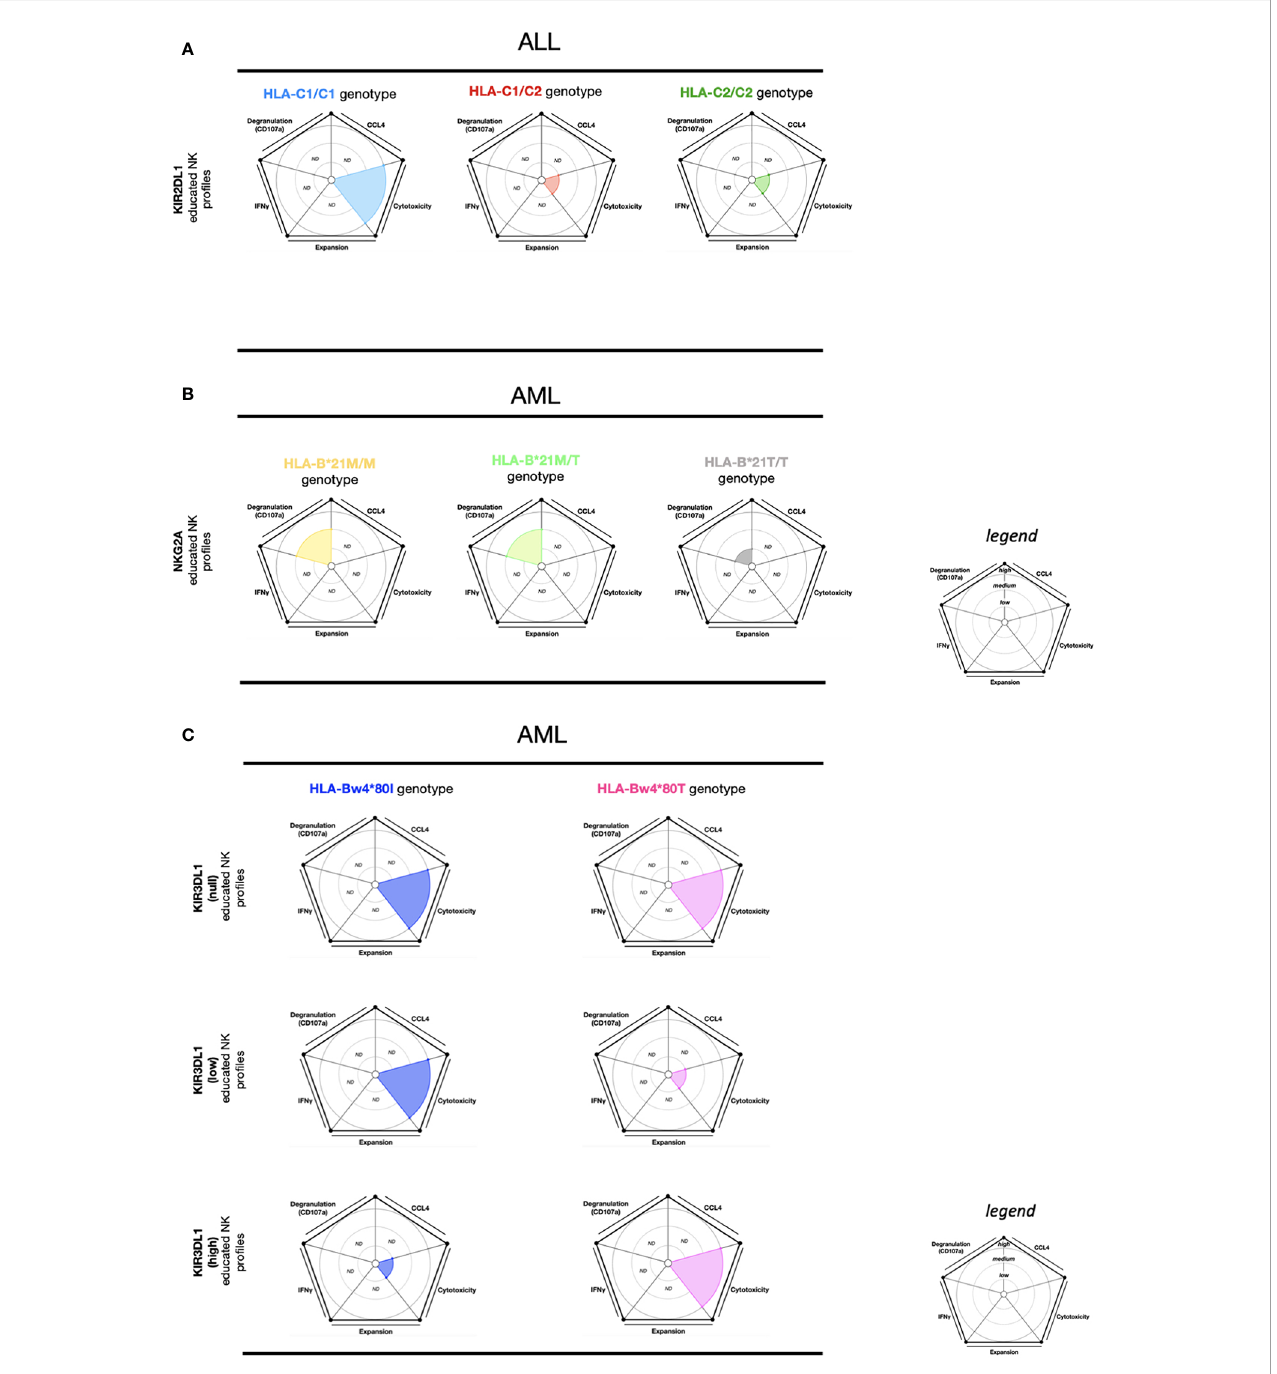
FIGURE 4 NK cell education pro fi les related to ALL and AML tumors. The different colors each represent a speci fi c-NKR educated NK pro fi le. Each educated NK pro fi les are de fi ned by fi ve factors (degranulation, CCL4, IFN g , cytotoxicity, and expansion). Each factor is described by the size of its slice on the pie chart according to three levels of reactivity (low, medium, high). (A) KIR2DL1 educated NK cells present three educated NK pro fi les according to HLA-C1/ C1, HLA-C1/C2, and HLA-C2/C2 genotypes. The NK educated reactivity represented in these charts was adapted via in vitro ALL blast stimulation (96). (B) NKG2A educated NK cells present three educated NK pro fi les according to HLA-B-21M/M, HLA- B-21M/T, and HLA- B-21T/T genotypes. The NK educated reactivity represented in these charts was adapted via in vitro AML blasts with IL- 2 stimulation (97). (C) KIR3DL1 educated NK cells present six educated NK pro fi les according to HLA-Bw4*80I and HLA-Bw4*80T genotypes and associated with the expression of KIR3DL1 (null, low, and high). The NK educated reactivity represented in these charts was adapted via in vitro AML cell line stimulation (98). ND, no data is